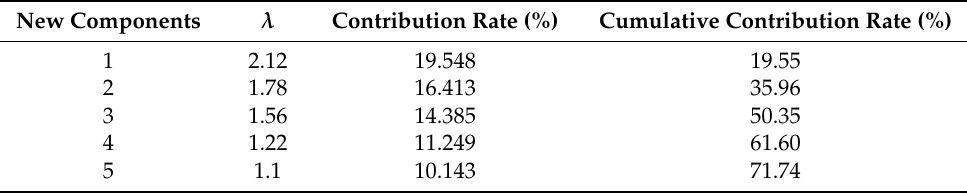
Table 2. λ and contribution rate of each new component.